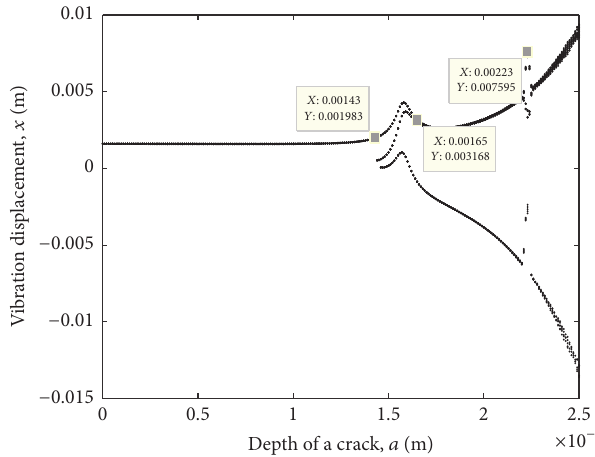
Figure 19: Bifurcation diagram with depth of a breathing